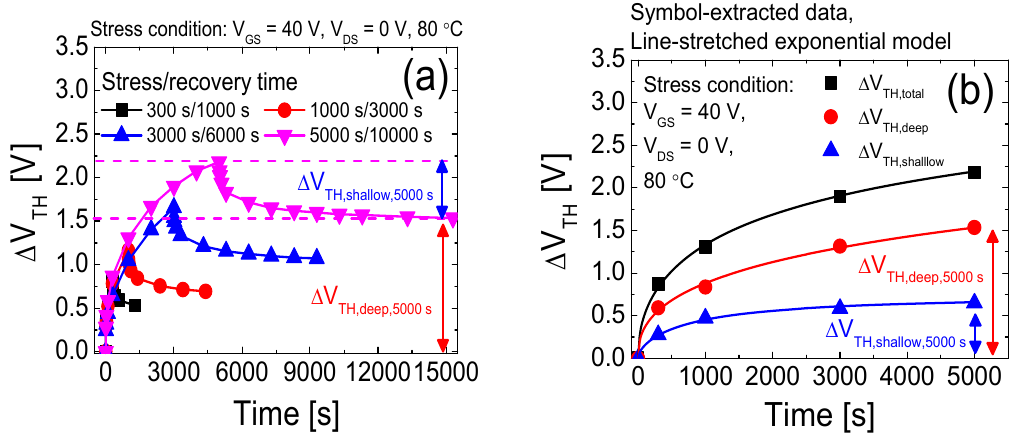
Figure 5. ( a ) Time evolution of Δ V TH at different stress/recovery time pairs. ( b ) Time evolution of the PBTS ‐ induced Δ V TH s for the recoverable and non ‐ recoverable trapped electrons obtained by applying the stress ‐ time ‐ divided measurement technique to ( a ).